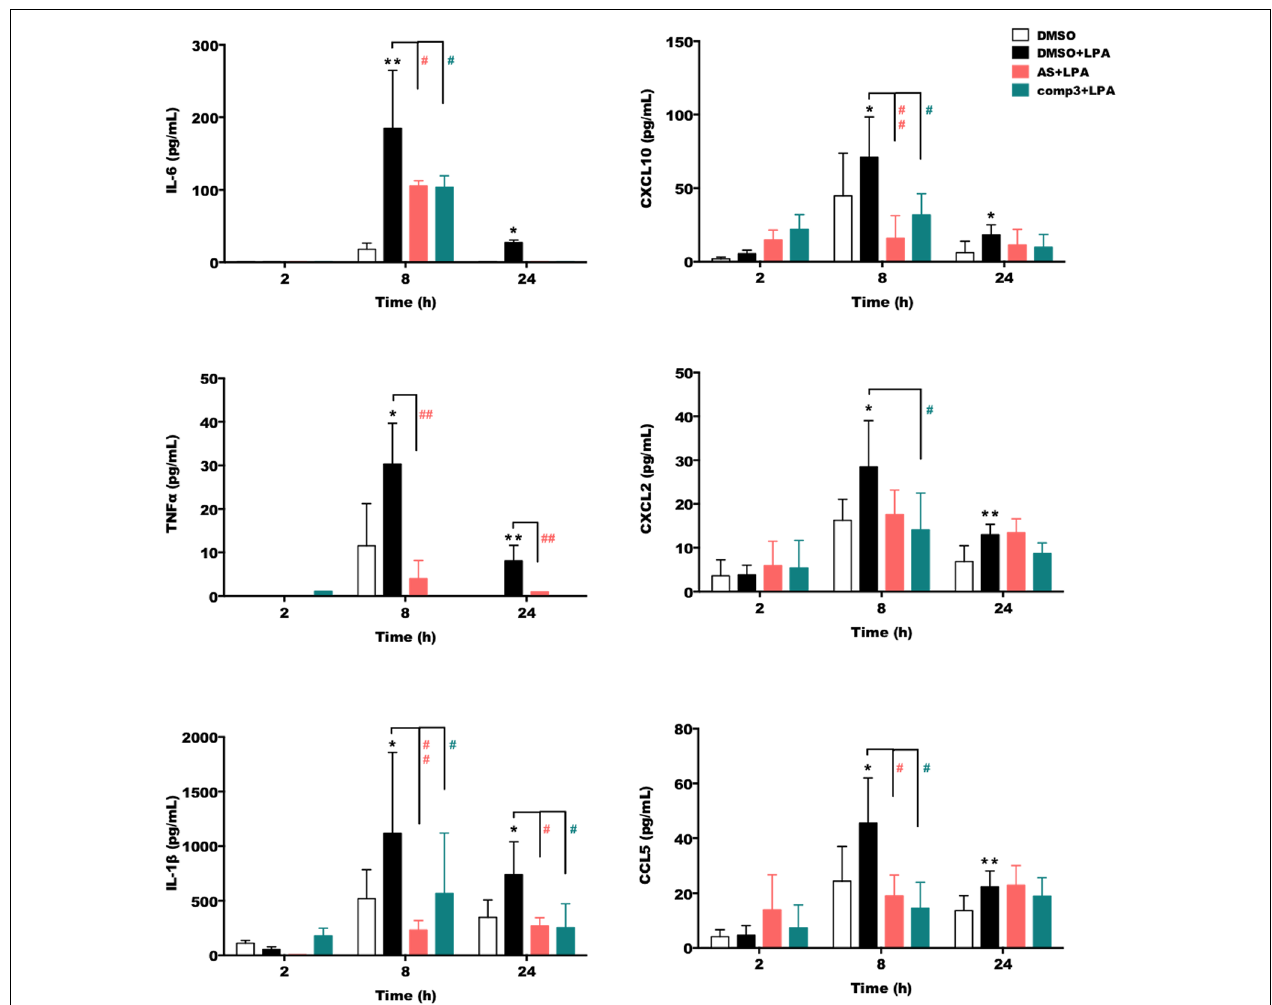
FIGURE 3 | AS2717638 and compound 3 reduce LPA-mediated secretion of pro-inflammatory cytokines and chemokines. BV-2 microglia were cultured on 24-well plates and serum-starved o/n. The supernatants were collected after incubation with vehicle control (DMSO), DMSO plus LPA (1 µ M) or LPA plus AS2717638 (0.1 µ M) or compound 3 (1 µ M) for 2, 8, and 24 h. ELISA was used to quantify the concentrations of IL-6, TNF α , IL-1 β , CXCL10 (IP-10), CXCL2 (MIP-2), and CCL5 (RANTES). Results shown represent mean ± SD from three independent experiments performed in triplicate ( ∗ p < 0.05; ∗∗ p < 0.01 compared to vehicle control; # p < 0.05, ## p < 0.01; each inhibitor compared to LPA-treated cells; one-way ANOVA with Bonferroni correction). No bars = below detection